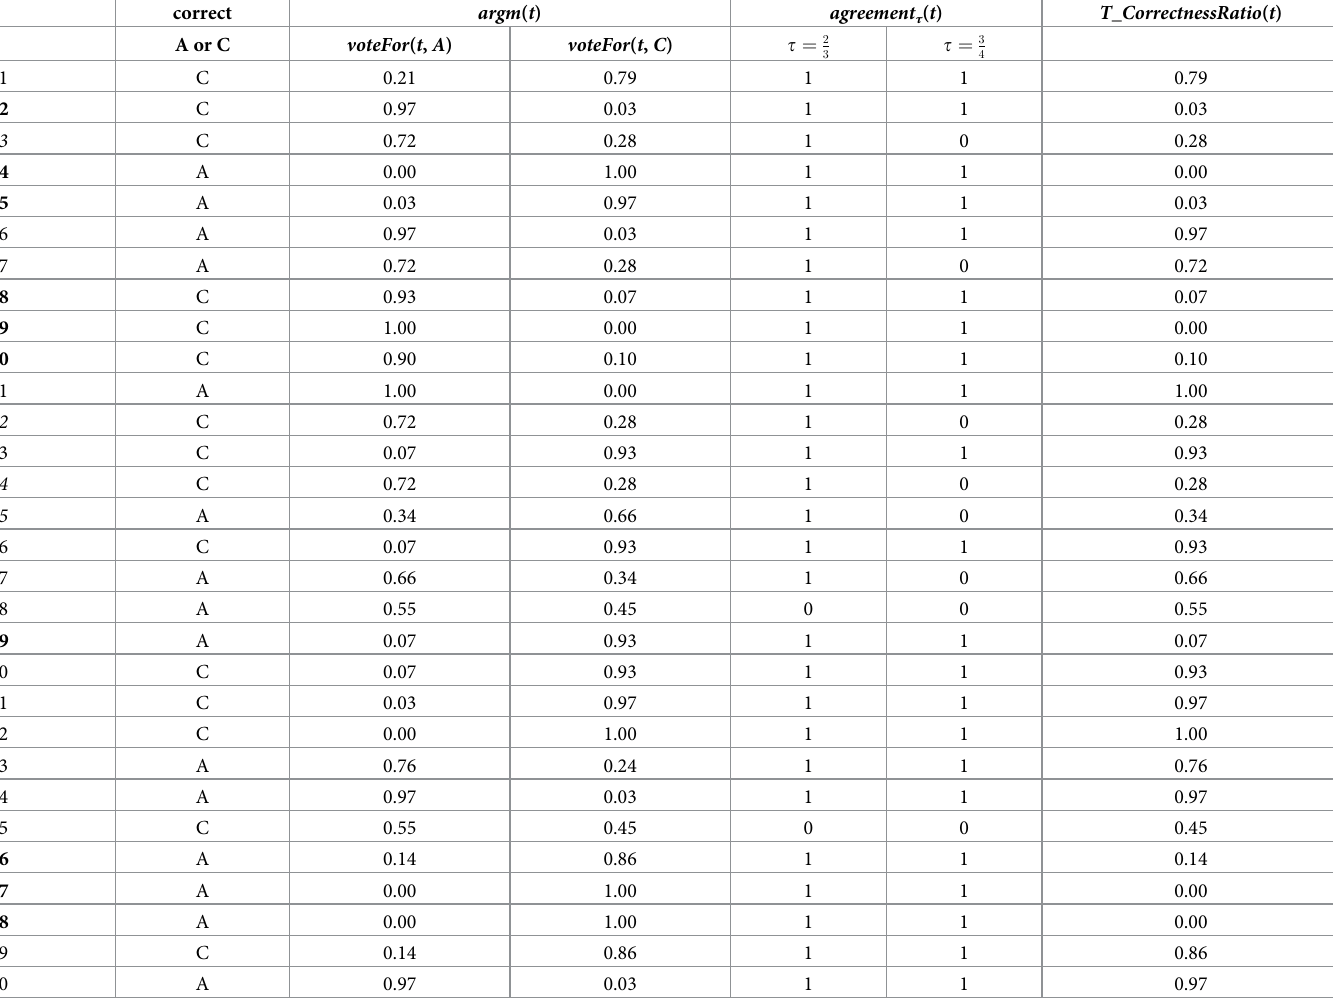
Finally, we inspected the agreement of annotators towards each triplet and juxtaposed it to the correctness towards triplet. The results are depicted on Table 7. The last column of Table 7 shows the aggregated correctness of the 29 annotators T _ Cor- rectnessRatio for each triplet t , while the previous two columns depict the level of agreement for t among the annotators agreement ( t ), for two threshold values. To juxtapose correctness τ with agreement, we show in the second column the correct value for the triplet, i.e. A or C, while the next two columns show the ratio of votes of the annotators for each of A and Table 7. Juxtaposition of annotator performance (last column) and agreement on triplet for t ¼ 2 and t ¼ 3 . We mark in bold the triplets for which experiment partic- 3 4 ipants agreed on the wrong value for both thresholds, and in italic the triplets for which experiment participants agreed on the wrong value only for t ¼ 2 3